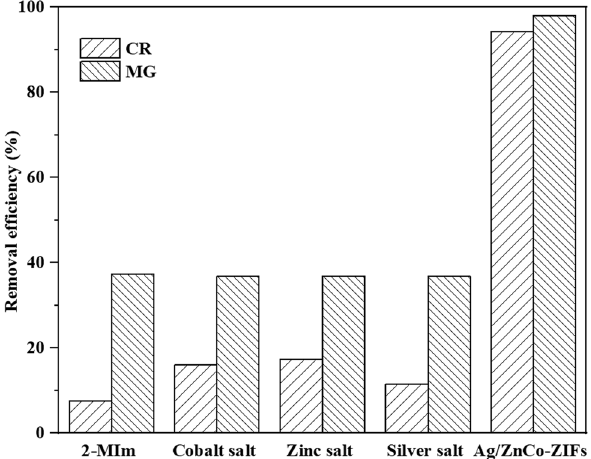
Figure 6: Comparison of CR and MG removal e ffi ciency among homogeneous catalysts and Ag/ZnCo -